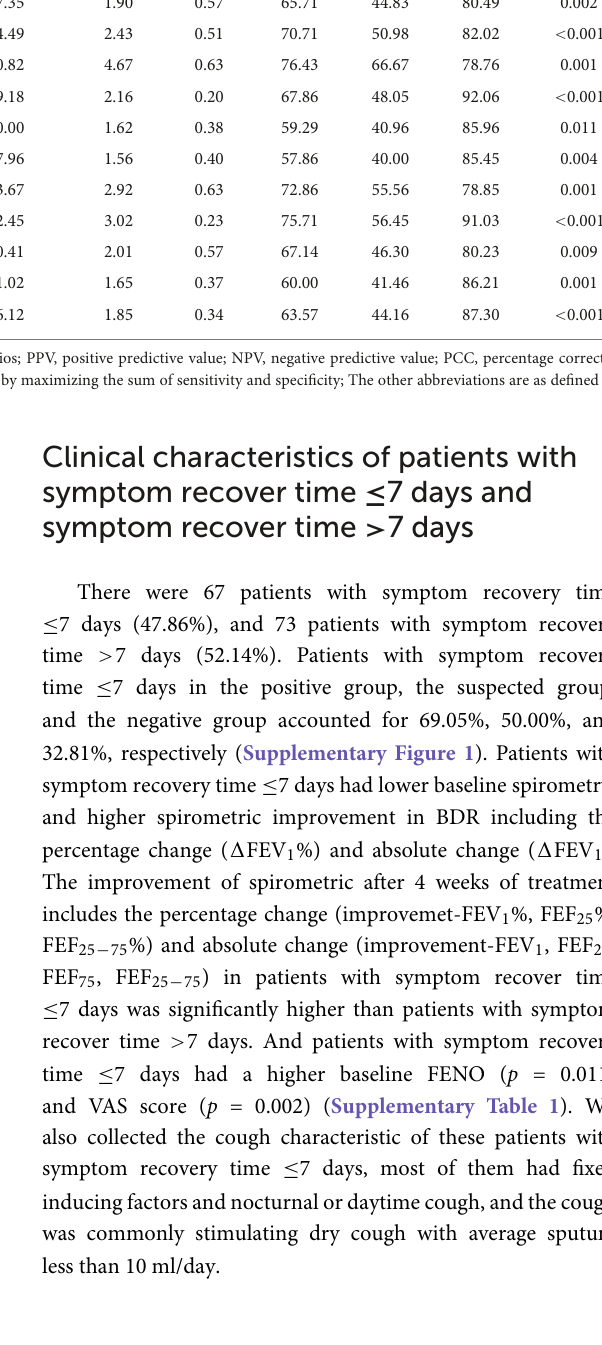
TABLE 2 Optimal cut-off values for the prediction of CVA positive diagnosis. Characteristics and variables